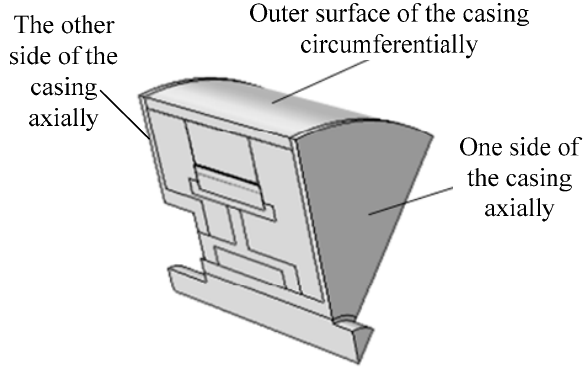
Figure 12. Casing surfaces.